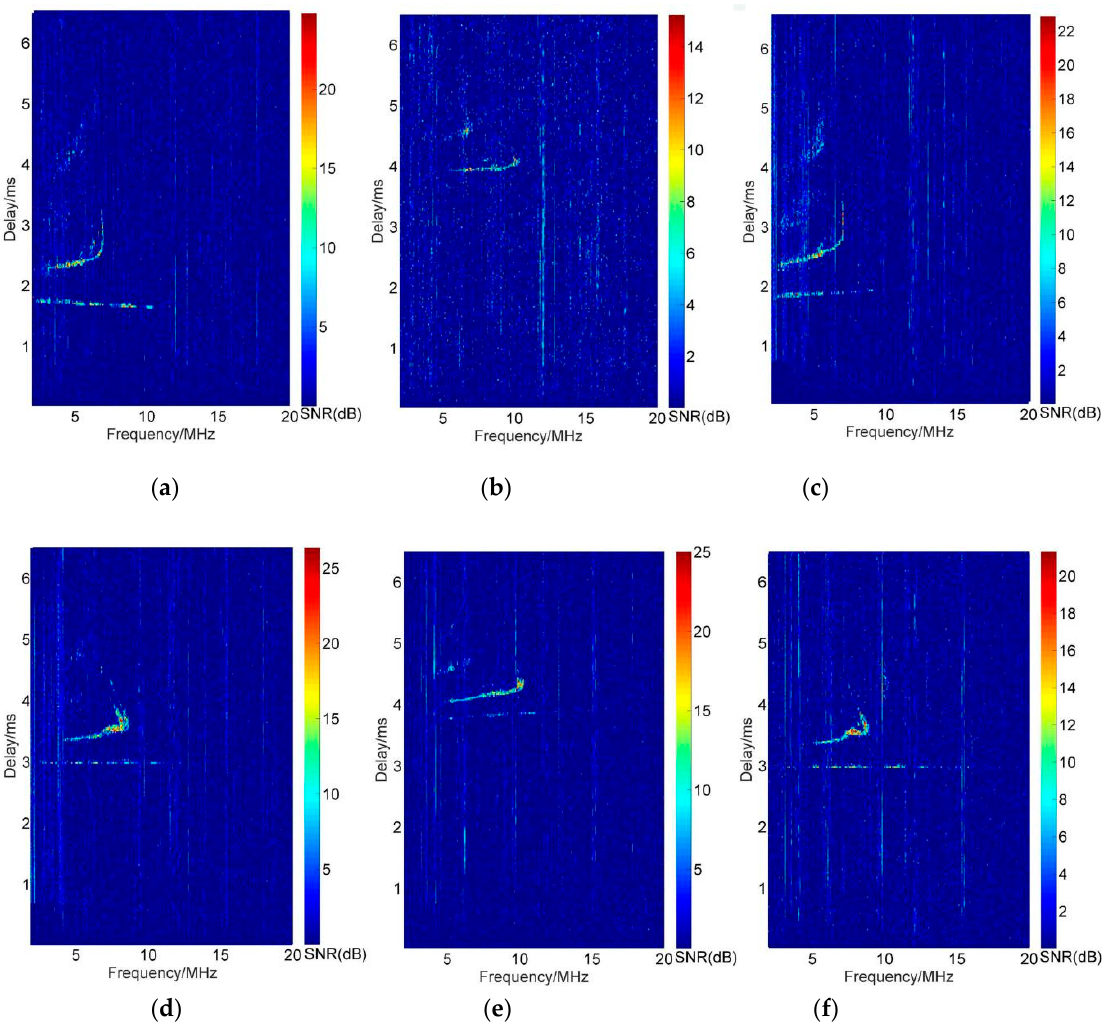
Figure 7. Oblique ionograms of manually orthogonal complete complement sequences: ( a , b ) are oblique ionograms of the received signals of Leshan decoded by the sequences of Ningqiang and Wuhan [16]. ( c , d ) are the results of the received signals of Ningqiang decoded by the sequences of Leshan and Wuhan respectively. ( e , f ) are the ionograms of Wuhan decoded by the sequences of Leshan and Ningqiang.